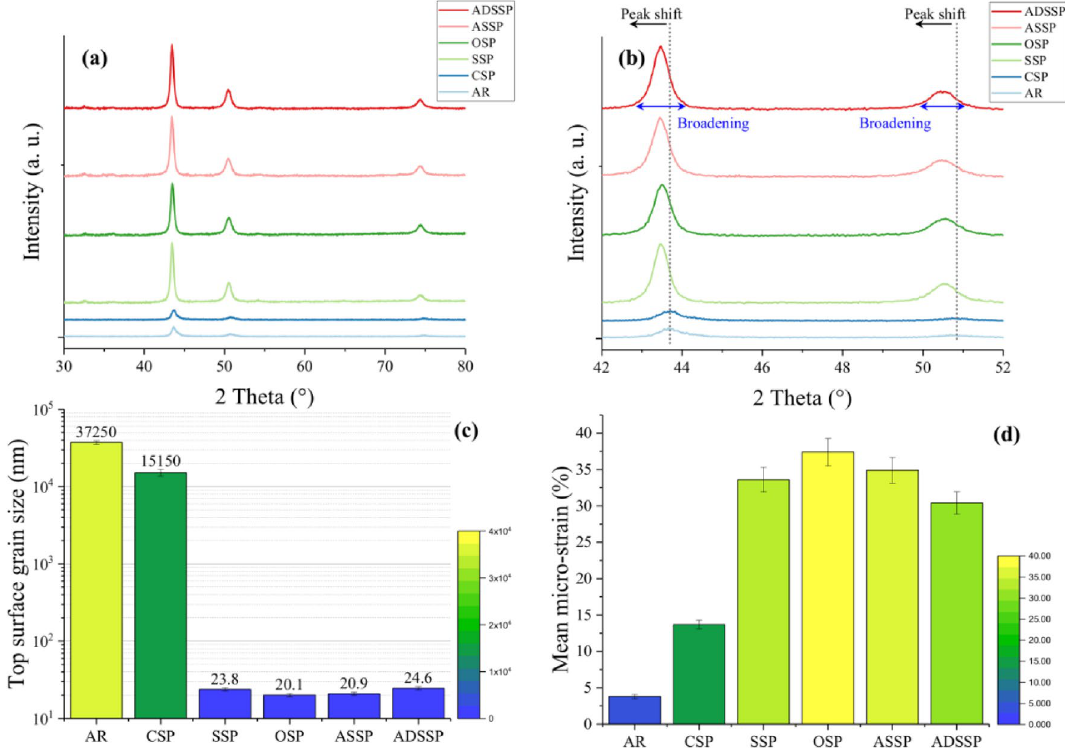
Figure 6. XRD patterns of the AR and SP treated specimens along different diffraction angles of 2θ in different ranges of ( a ) 30°–80°, ( b ) 42°–52° ( c ) Top surface grain size for AR and treated specimens obtained by OM for AR and CSP specimens and achieved by XRD analyses for the other severely and overly shot peened ones ( d ) Measured micro-strain in all sets of specimens obtained by XRD.